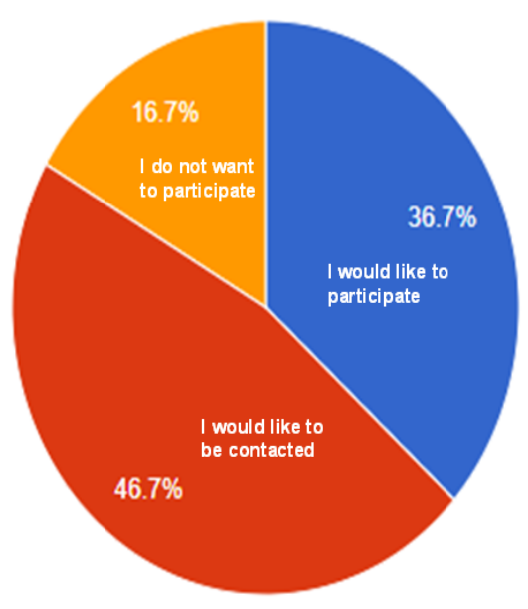
Figure 6. Pie chart of willingness to participate in future studies.